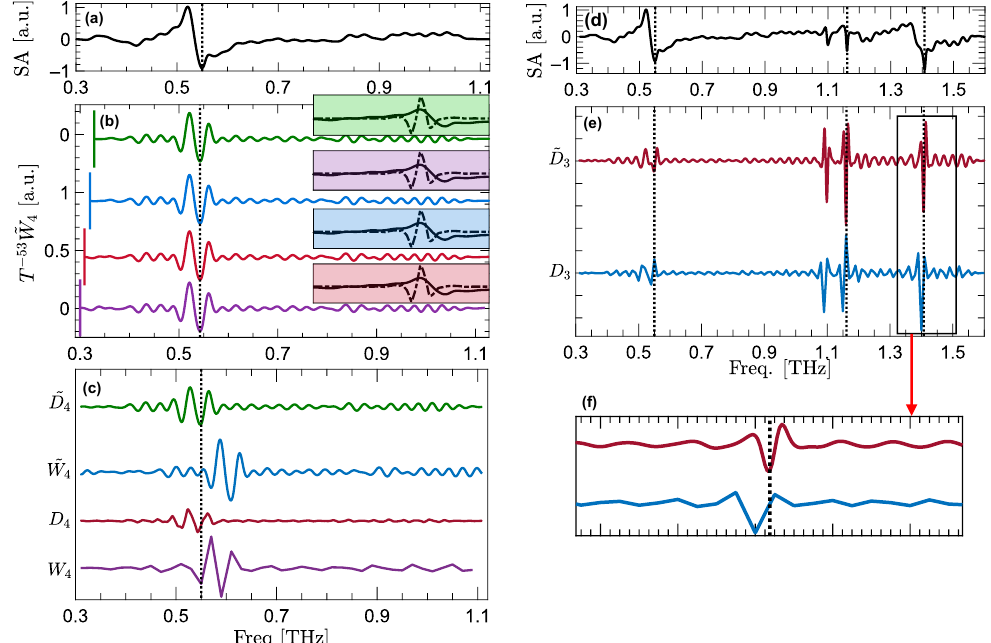
Figure 3. ( a ) The SA of α -lactose over the frequency range of f = 0.3–1.13 THz as the control sample. ( b ) The vertically-offset fourth-level MODWT wavelet coefficients of the SA signal, applied in the frequency domain. Each line in ( b ) is calculated over a different frequency range, including f = 0.30–1.10 THz in the purple line, f = 0.31–1.11 THz in the red line, f = 0.32–1.12 THz in the blue line, and f = 0.33–1.13 THz in the green line. The lower bound of the frequency ranges are emphasized using vertical lines at the beginning of each trace. Each inset box, shaded with the same color, shows the overlap between the wavelet filter (dashed line) and the resonant signature (solid line) at 0.53 THz in the corresponding reflection spectra. ( c ) The vertically-offset fourth-level DWT and MODWT wavelet and details coefficients of the SA signal. Panel ( d ) shows the SA of α -lactose over the entire measurement bandwidth of f = 0.3–1.6 THz. In ( e ) are the vertically-offset third-level DWT and MODWT details vectors of the SA signal in ( d ). Panel ( f ) zooms into the details coefficients around 1.4 THz, revealing that the DWT details vector (blue line) is slightly misaligned with respect to the resonant frequency, while MODWT details vector (red line) maintains the exact spectral location. The vertical dashed lines in ( a – f ) delineate the resonances of α